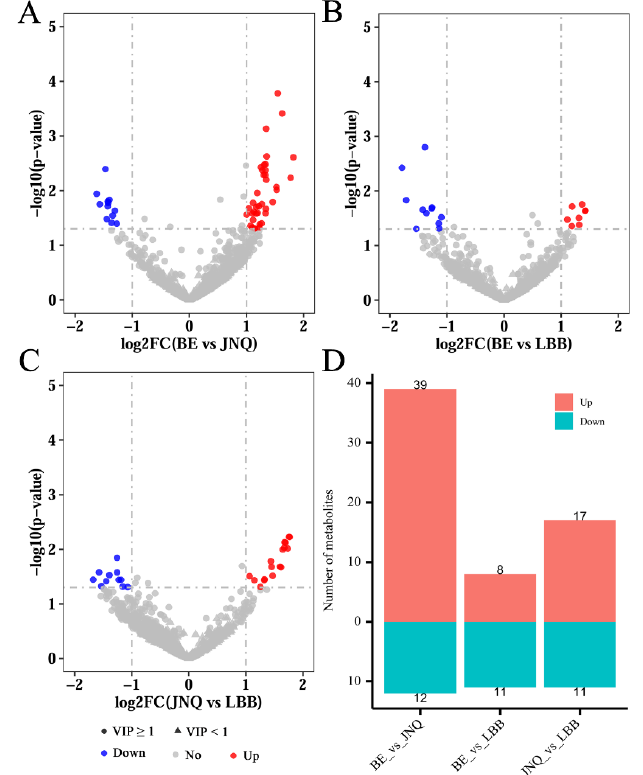
Figure 4. Volcano plots showing the distribution of all metabolites based on their fold-change values (x-axis, on a logarithmic scale), p -values (y-axis, on a logarithmic scale), and VIP scores (shape; circle for VIP ≥ 1 and triangle for VIP < 1). A comparison is made between ( A ) the BE group and JNQ group, ( B ) the BE group and LBB group, and ( C ) the JNQ group and LBB group. Up-regulated, down-regulated and non-di ff erential metabolites are colored in red, blue and gray, respectively. ( D ) The numbers of up-regulated (red) and down-regulated (blue) metabolites between each two experimental